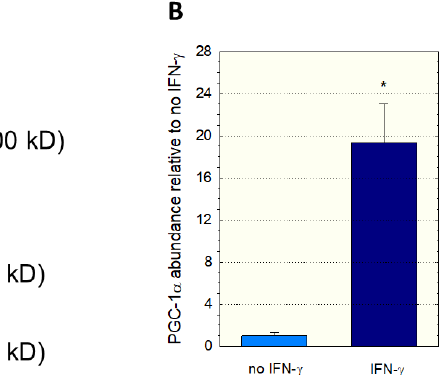
Figure 5. Interaction between PGC1α and MEF2. C2C12 myoblast lysates were incubated with anti - MEF2 antibodies, and the separated precipitates assayed using anti-MEF2 and anti-PGC- 1α anti- bodies. The corresponding immunoblots are shown in ( A ) and the quantification of the PGC- 1α band in ( B ). Treatment of C2C12 myoblasts with interferon- γ was performed for 12 h. Interferon - γ activates the p38 MAP kinase (p38 MAPK), which activates MEF2. Data are presented as the mean ± SD of n = 3 independent observations. * p < 0.05 vs. incubations without IFN- γ.